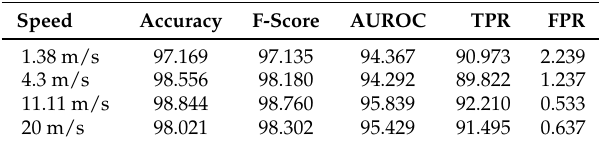
Table 5. Cluster-based detection per network mobility (Network of 50